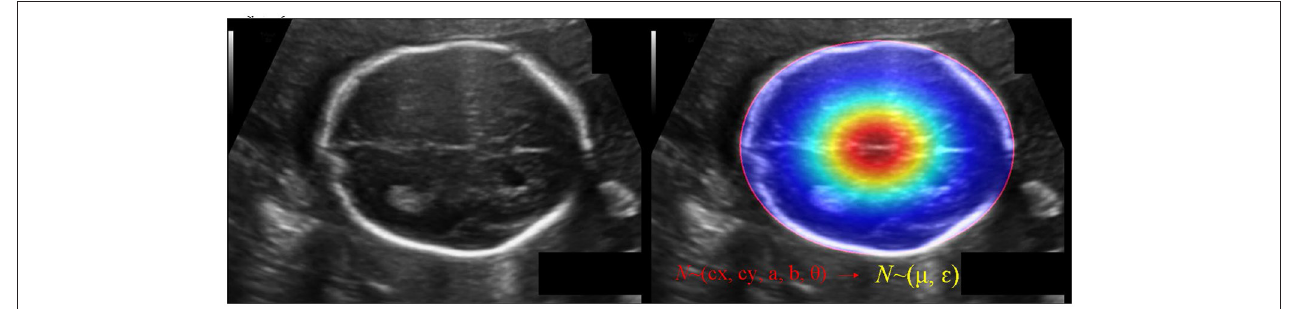
FIGURE 6 | The schematic diagram of converting GT of the ellipse ( c x , c y , a, b, θ ) into a 2-D Gaussian N ( µ , ε ).